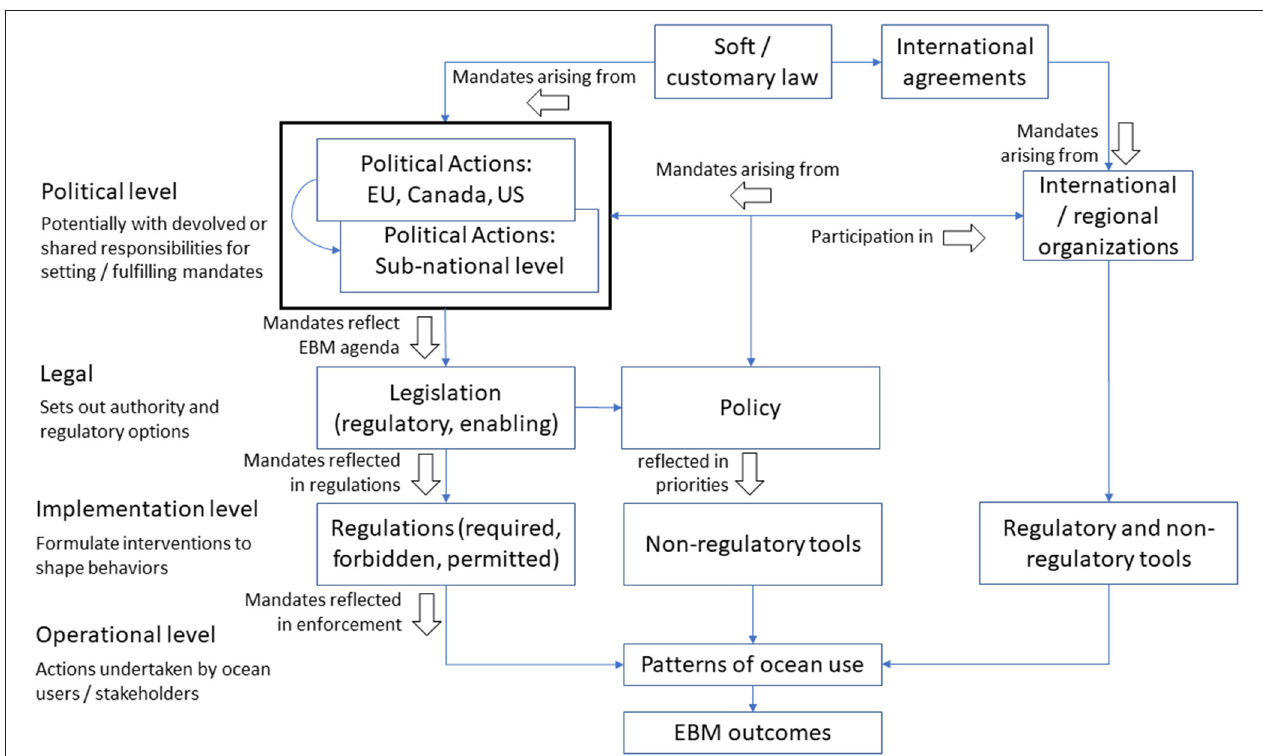
FIGURE 1 | The conceptual multi-level approach used by the task group depicting political mandate, legislative structure, and non-regulatory implementing policy (adapted from Link et al.,